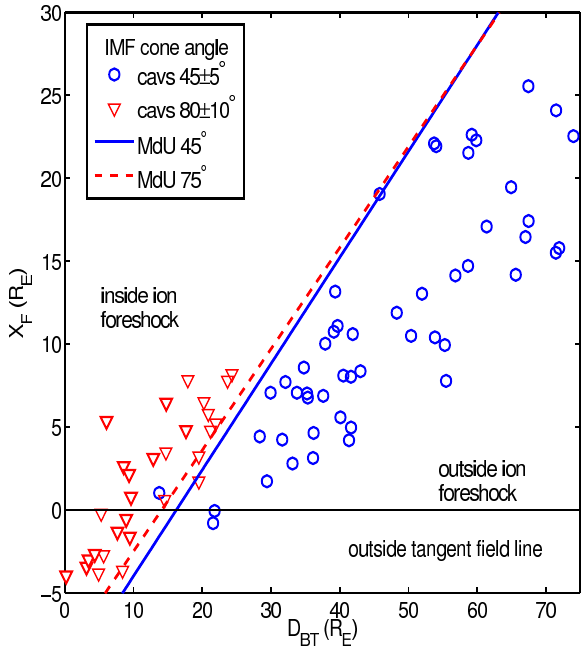
Fig. 6. SFC scatter plot of foreshock cavities observed for IMF cone angles 80 ◦ ± 10 ◦ (red triangles) and those observed for IMF cone angles 45 ◦ ± 5 ◦ (blue circles). The solid line indicates the intermediate ion foreshock boundary reported by Meziane and d’Uston (1998) for cone angles of 45 ◦ ± 5 ◦ , and the dashed line the same boundary for cone angles of 75 ◦ ± 5 ◦ . The boundaries reported by Meziane and d’Uston (1998) for cone angles of 75 ◦ and 85 ◦ are not significantly different (the gradients and intercepts of the linear fits are the same to within the errors reported). As relatively few foreshock cavities are observed for high cone angles, we employ wider bins.